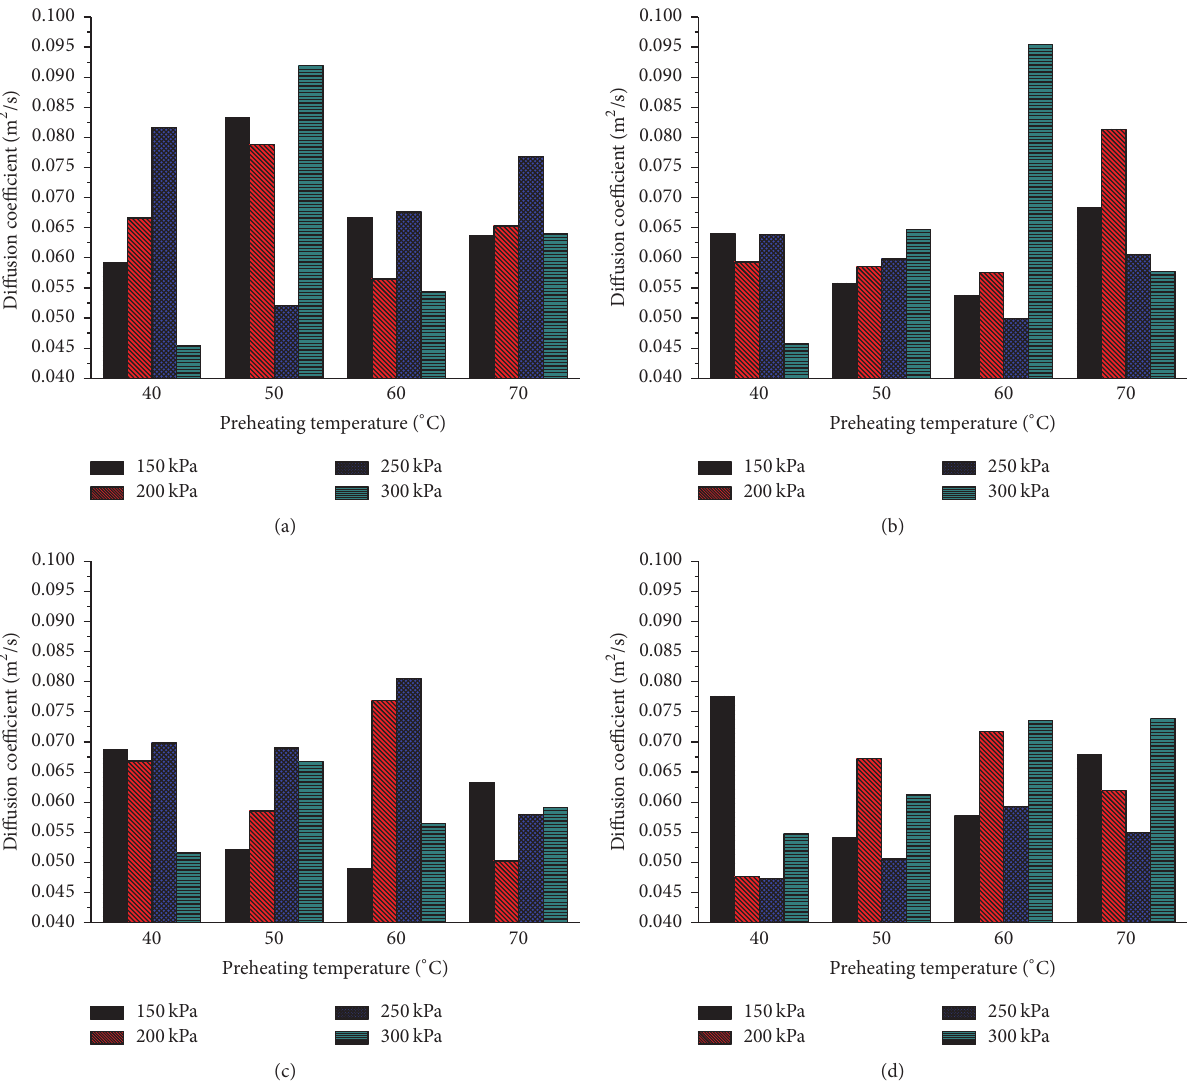
Figure 12: The DC of epoxy resin in carbon fiber surface under the different processing parameters: (a) laying speed of 27 m/min; (b) laying speed of 30 m/min; (c) laying speed of 33 m/min; (d) laying speed of 36